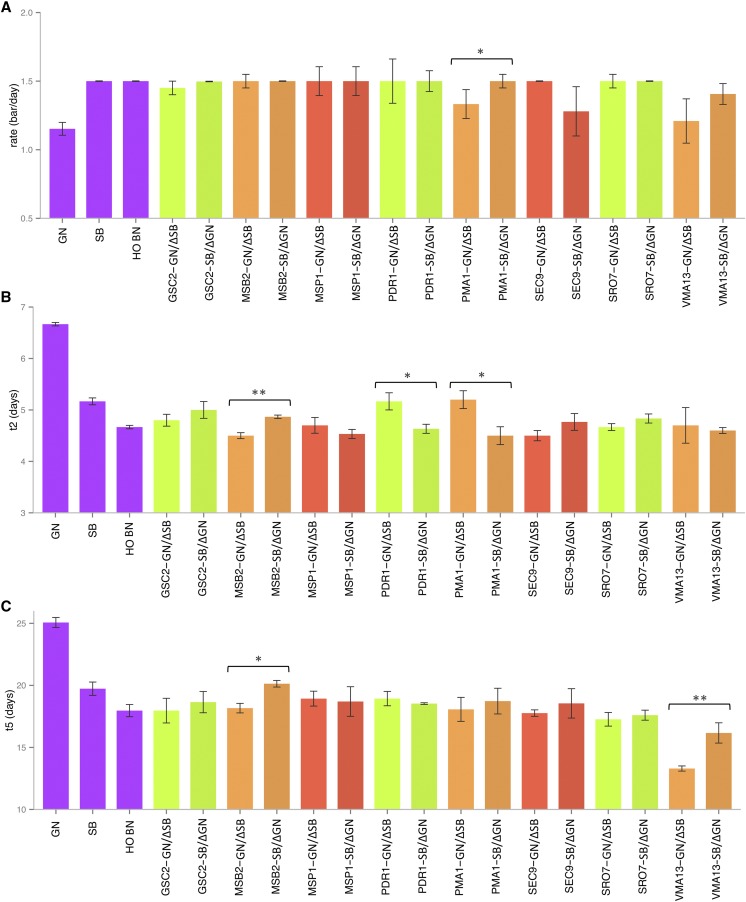
Results of the reciprocal hemizygosity analysis for the fermentative rate (A), t2 (B), and t5 (C). The represented value is the mean of three different biological triplicates; the SE is represented by error bars. An ANOVA was applied to assess the significance of the phenotypic difference between hemizygotes. The level of significance between hemizygotes is indicated as follows: * p ≤ 0.05, ** p ≤ 0.01, *** p ≤ 0.001.